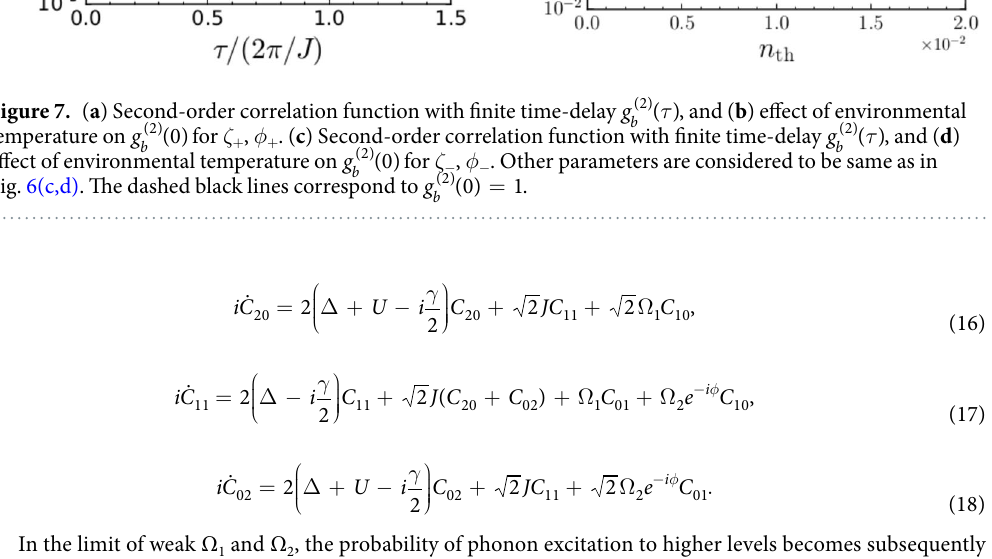
In the limit of weak Ω 1 and Ω 2 , the probability of phonon excitation to higher levels becomes subsequently lower i.e. . The optimal condition for the complete phonon blockade in the 02 primary resonator corresponds to the case when the probability of a phonon in state |20 〉 equals zero. Under these assumptions, solving Eqs (14) and (15), the values of C 10 and C 01 at the steady-state are obtained as Ω =